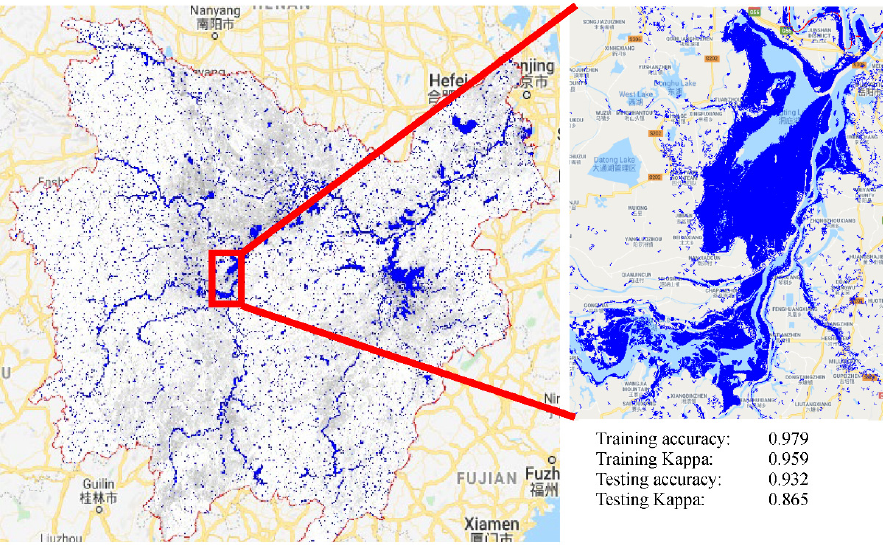
Figure 8. Exclude permanent water body.